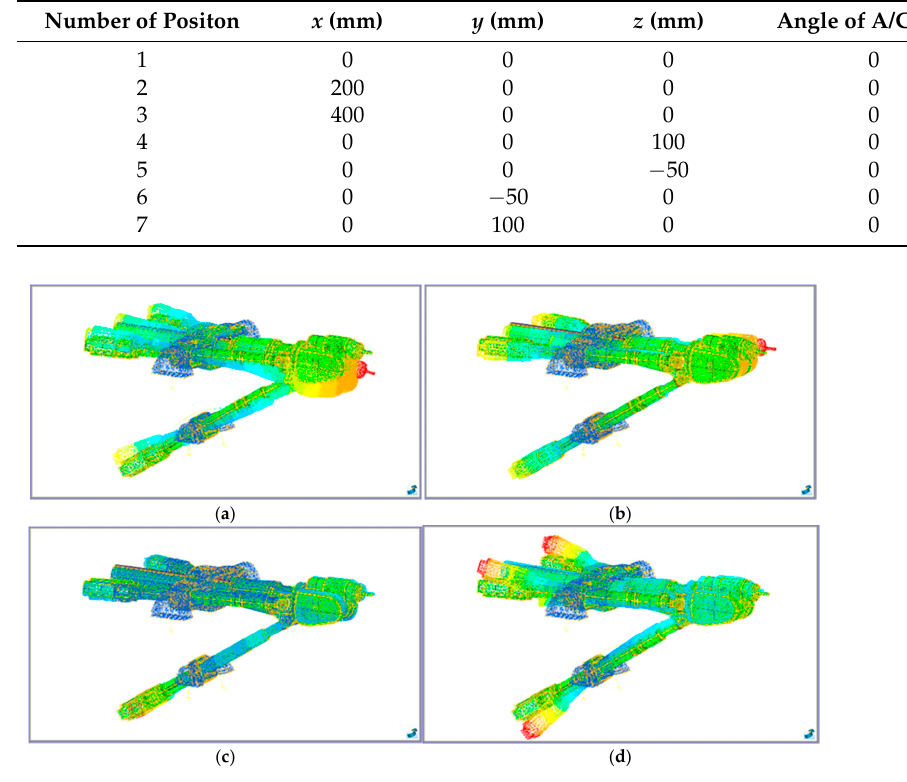
Figure 3. The mode shapes of the first 4 order simulation modes of the PKM at initial position. ( a ) 1st mode shape of vibration; ( b ) 2nd mode shape of vibration; ( c ) 3rd mode shape of vibration; and ( d ) 4th mode shape of vibration.